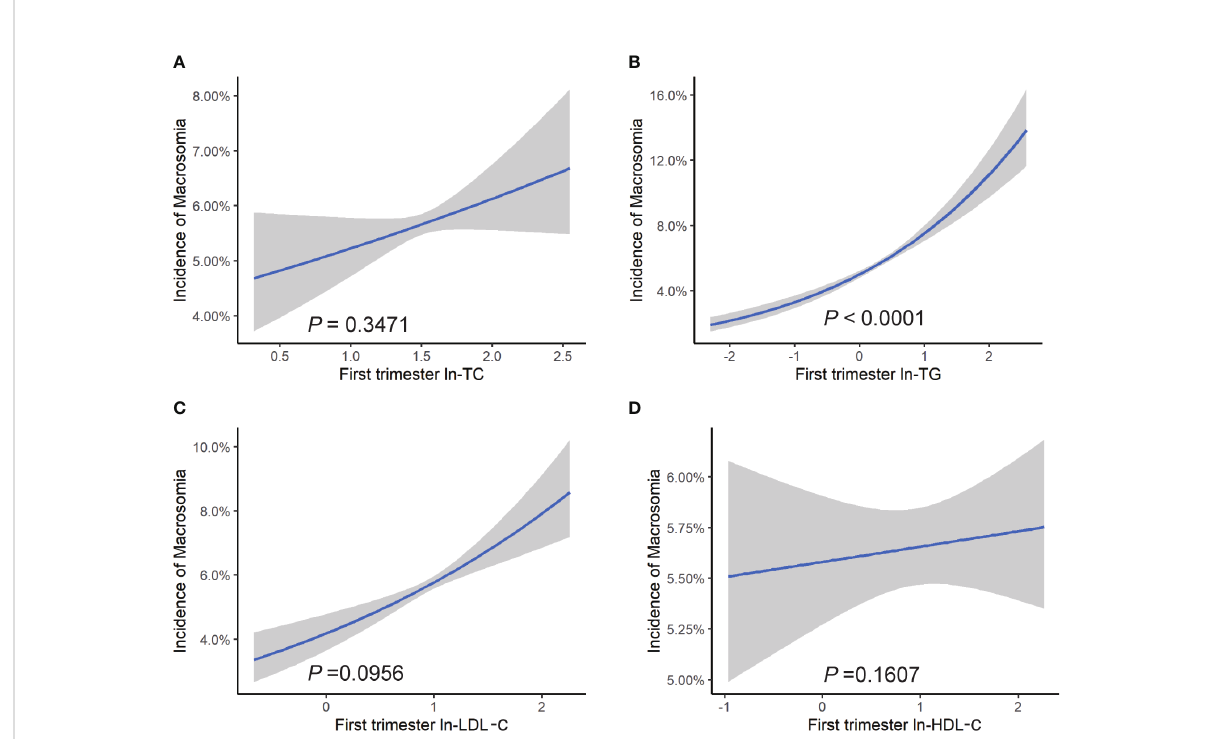
FIGURE 2 Risk of macrosomia associated with maternal lipid pro fi les in early pregnancy. Logistic regression models for ln transformed (A) TC, (B) TG, (C) LDL-c, (D) HDL-c, and macrosomia, expressed as predicted mean with 95% CIs. Analyses were adjusted for maternal pre-pregnancy BMI, age, mode of conception, parity, education, consumption of cigarettes, infant sex, gestational diabetes, and gestational hypertension